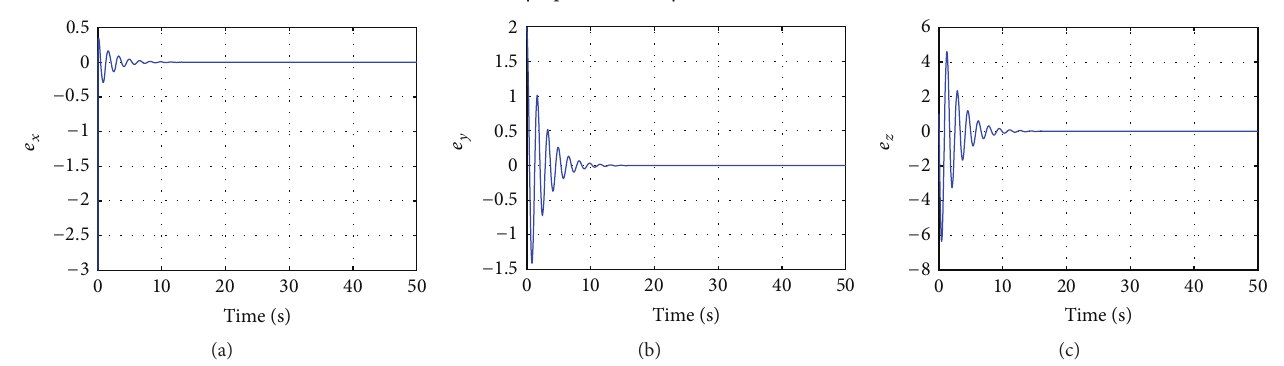
Figure 3: The asymptotic stability of 𝑆 − with controller (28).